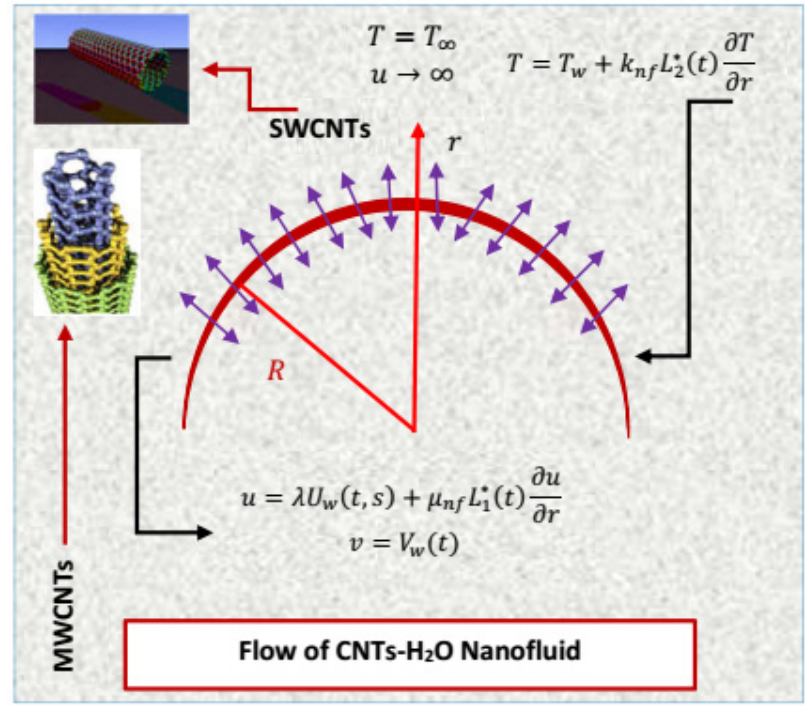
Figure 1. Flow of CNTs-H 2 O colloidal suspension over curved stretching/shrinking surface.